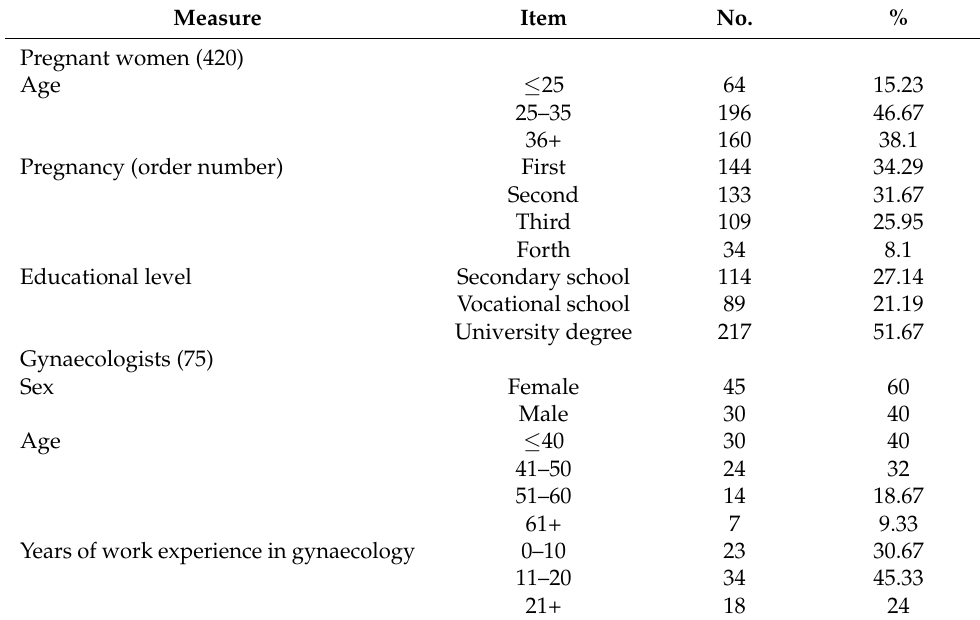
Table 1. Demographic information related to the